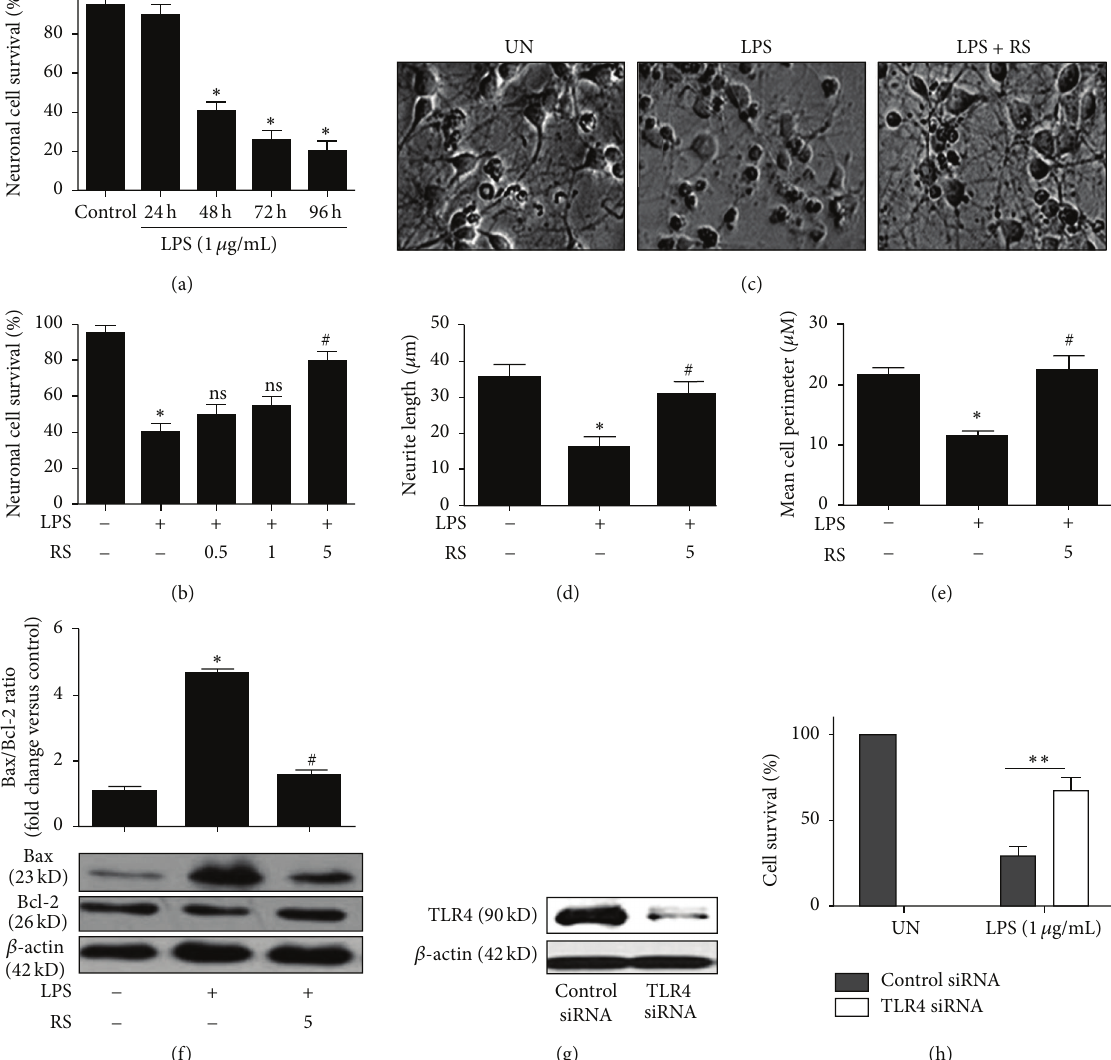
Figure 3: LPS-Rs ameliorates microglia-mediated neuronal insults. BV2 cells were differentially treated in absence and presence of LPS- Rs followed by LPS treatment as indicated. Later the differentiated neuro2a cells were cocultured with BV2 cells and neuronal viability was measured using MTT and morphological observation (b, c, d). Supernatants from conditioned microglial cells were used to treat differentiated neuro2a cells and the Bax: Bcl2 ratio was measured following Western blot (e). BV2 cells were transfected with control or TLR4 siRNA and TLR4 silencing was assayed by Western blot (f). TLR4 silencing suppressed LPS induced neuronal cell death (g). The error bars represent the mean ± SEM from three independent experiments ( ∗ 𝑝 ≤ 0.05 versus control and # 𝑝 ≤ 0.05 versus LPS). UN: untreated; LPS: lipopolysaccharide from Escherichia coli 055 : B5 (1 𝜇 g/mL); RS: lipopolysaccharide from Rhodobacter sphaeroides (0.5–5 𝜇